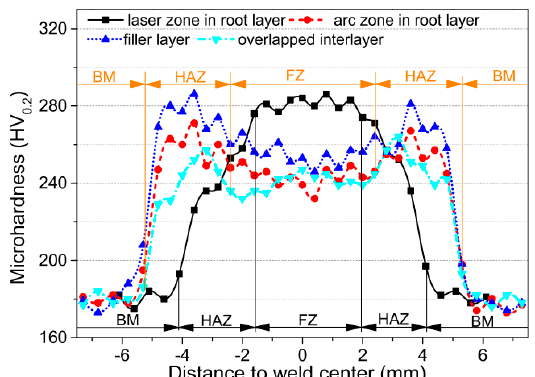
Figure 18. Horizontal profiles of the 40 mm Q235 mild steel joint (reproduced from [50] with permission, MDPI, 2017).